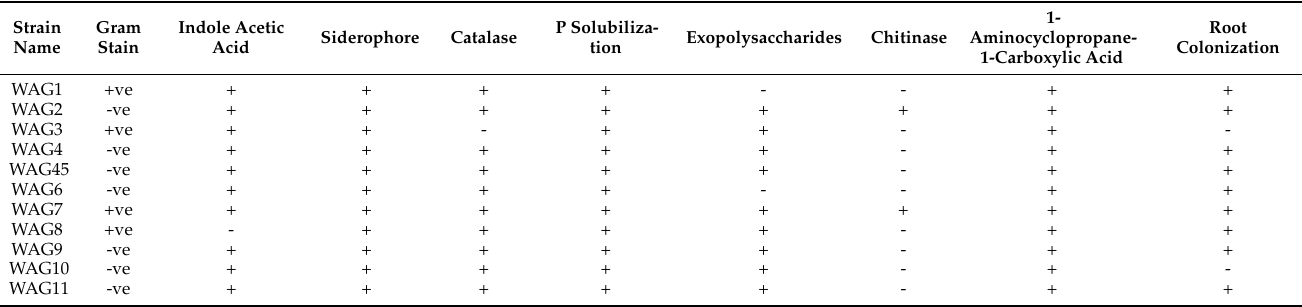
Table 2. Plants growth regulator traits of 11 glyphosate-degrading